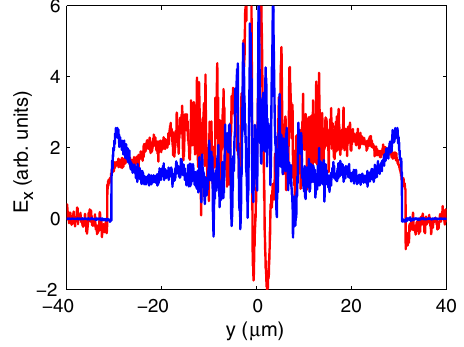
FIG. 3. The distribution of the axial electric field E hydrogen layer at t ¼ 80 T for with (red) and without (blue) the